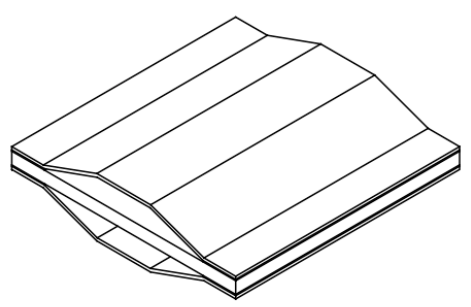
Figure 15. A derivative cymbal transducer with rectangular endcap.